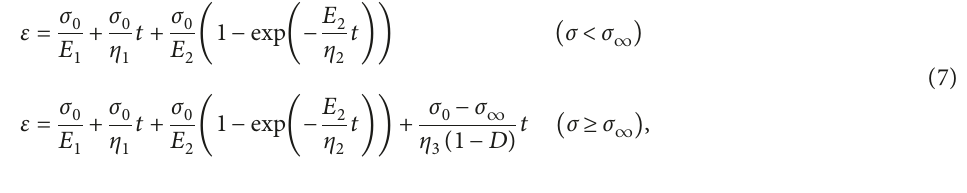
Figure 11. The creep parameters of this soil are shown in Table 6. It can be seen clearly that the creep experimental results of the Bayer red mud agree very well with the nu- merical prediction using the improved Burgers creep damage model, and square of the correlation coefficient ( R 2 )